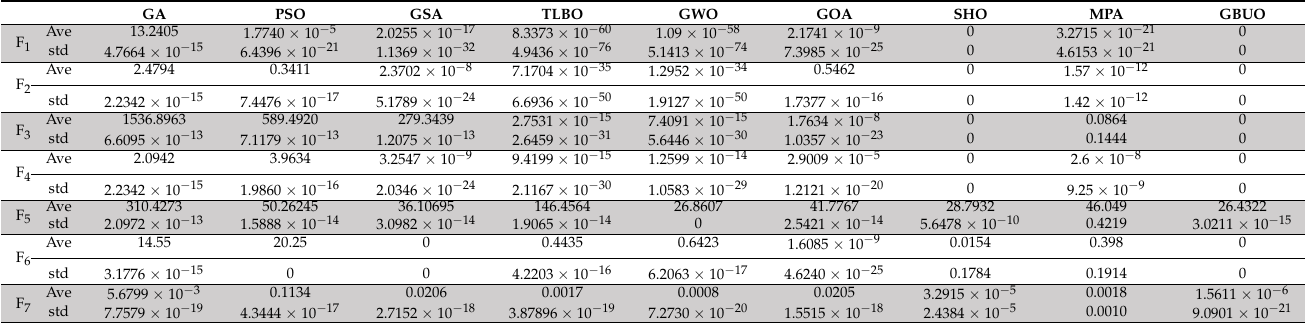
Table 3. Results of applying optimization algorithms on unimodal objective functions.